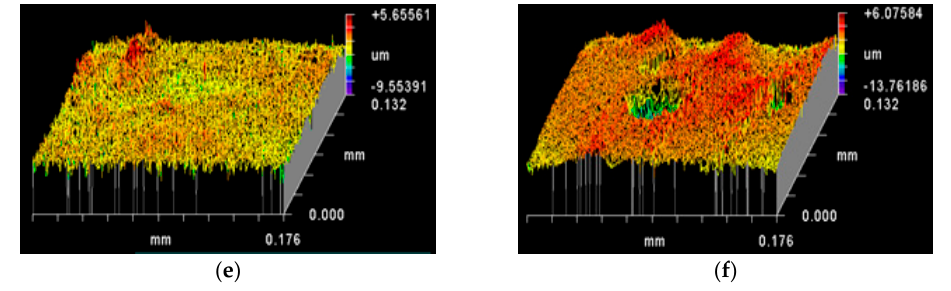
Figure 3. Effect of chemical etching treatments on surface topography (as mapped by Zygo interferometer): ( a ) native flattened Ag wire; ( b ) 30 s NH 4 OH; ( c ) 10 s HNO 3 ; ( d ) 2 m HNO 3 ; ( e ) 30 s NH 4 OH followed by 10 s HNO 3 ; and ( f ) 30 s NH 4 OH followed by 2 m HNO 3 etching treatments.